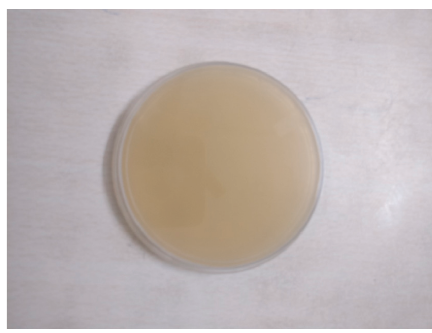
Figure 3: Culture plate.